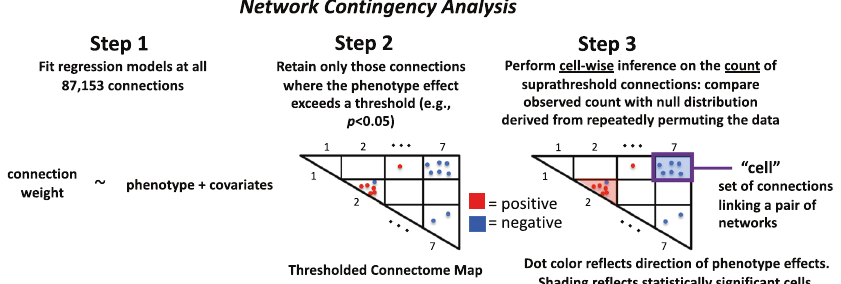
Fig. 1 Steps for network contingency analysis (NCA). NCA is a count-based method for quantifying altered connectivity at network cells, i.e., sets of connections linking pairs of large-scale networks. The method assesses, for each cell, whether the count of connections that are signi fi cantly related to the phenotye of interest exceeds the number expected by chance (based on non-parametric permutation